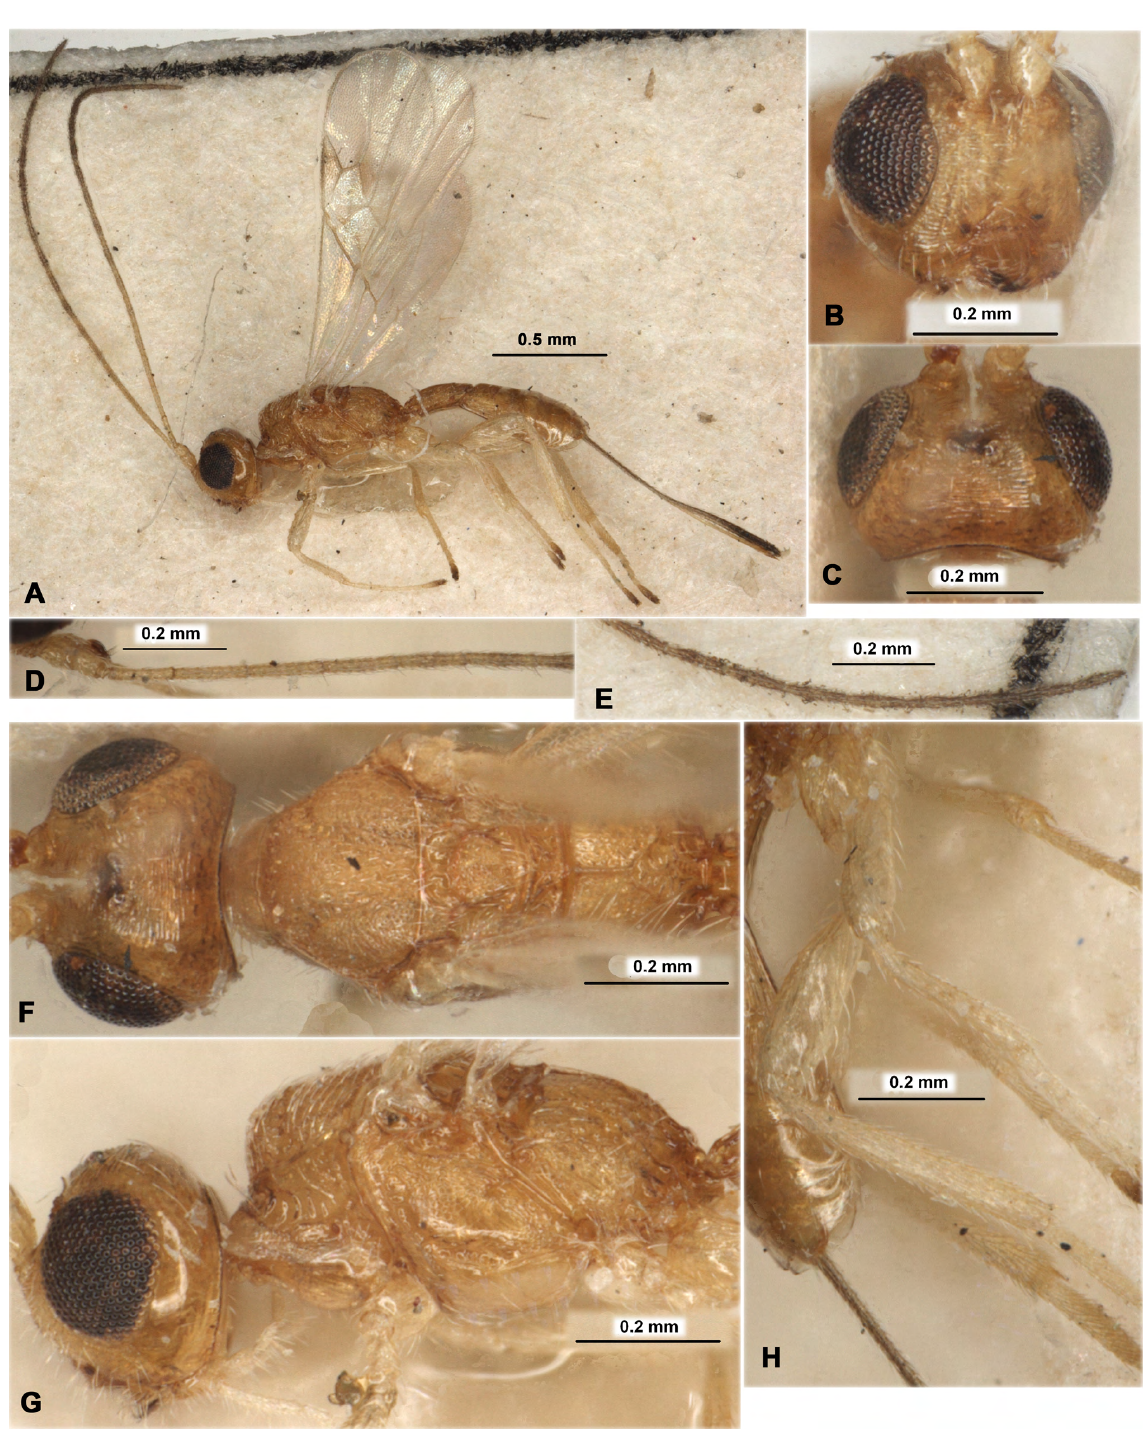
Fig. 54. Rhacontsira saigonensis sp. nov., ♀, holotype, MNHN. A . Habitus, lateral view. B . Head, front view. C . Head, dorsal view. D . Basal segments of antenna. E . Apical segments of antenna. F . Head and mesosoma, dorsal view. G . Head and mesosoma, lateral view. H . Hind leg, lateral